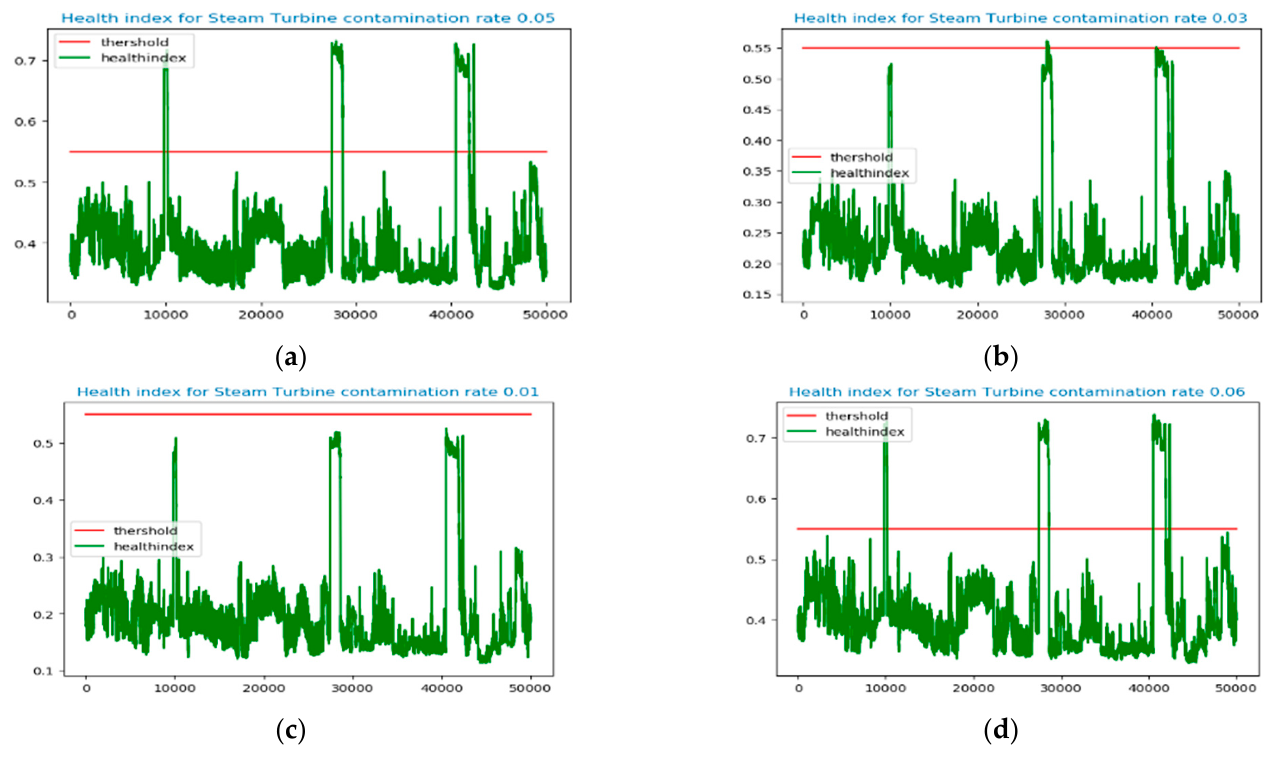
Figure 14. Health index for steam turbine through Isolation Forest with different contamination rates c = 0.05 ( a ); c = 0.03 ( b ); c = 0.01 ( c ); c = 0.06 ( d ). Table 5. Steam turbine health index forecasting.